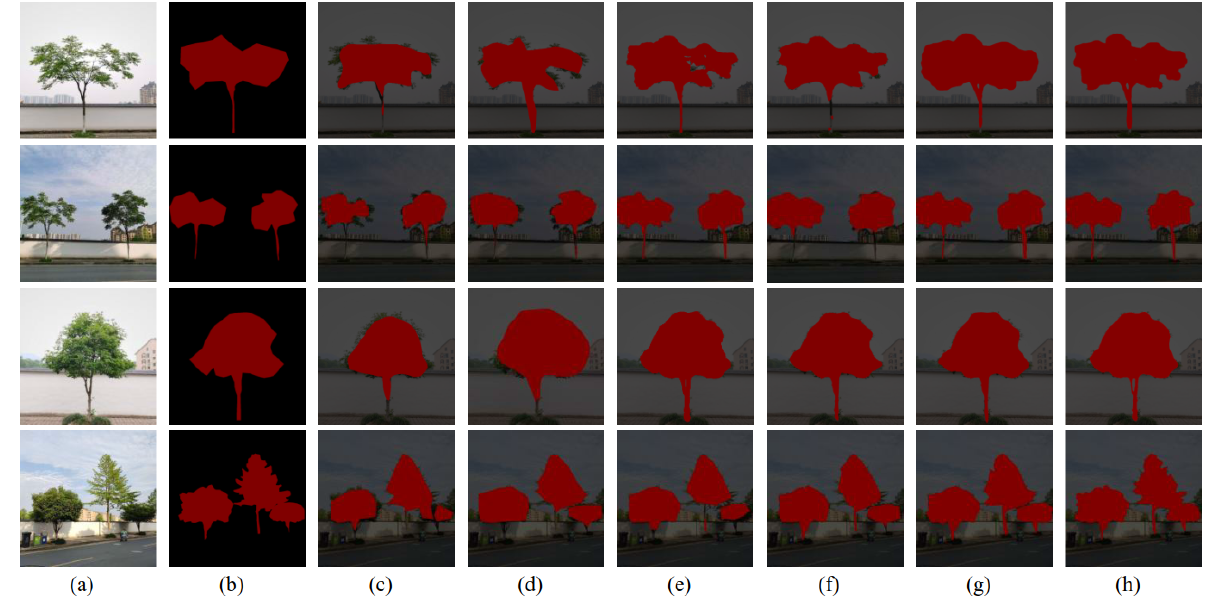
Figure 9. Comparison of standing tree segmentation under simple backgrounds. ( a ) Original image. ( b ) Ground-truth. ( c ) FCN. ( d ) SegNet. ( e ) U-Net. ( f ) PSPNet. ( g ) DeepLabV3. ( h ) SEMD.